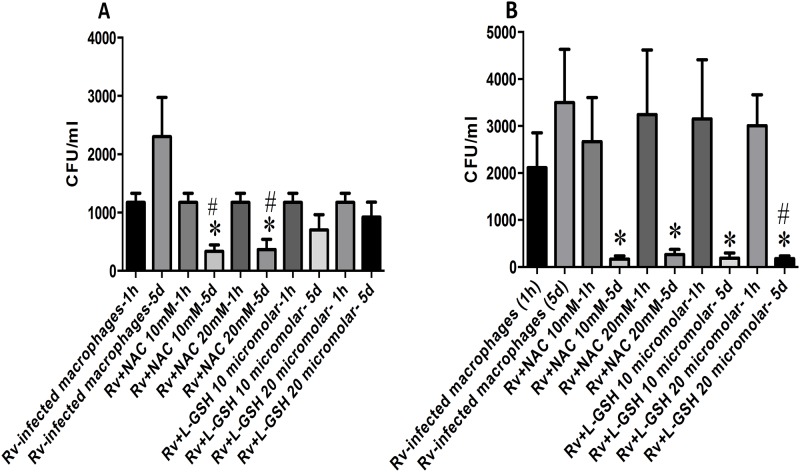
Intracellular survival of H37Rv in macrophages from healthy volunteers and individuals with T2DM.Macrophages were infected with H37Rv, a laboratory strain of M.tb, with multiplicity of infection 10:1. One hour post-infection, infected macrophageswere treated with 10 mM and 20 mM NAC and 10 μM and 20 μM lGSH. Infected macrophages were terminated at 1h and 5 days post-infection. Lysates were plated on 7H11 medium with ADC to determine M.tb growth. Data represent means ±SE from 5 healthy individuals (Fig. 9A) and 5 individuals with T2DM (Fig. 9B). Experiments were performed in triplicates. *p<0.05 when comparing H37Rv-infected macrophages 5 day time point results to any other 5 day time point categories while #p<0.05 when comparing 1 hour and 5 day time points of the same treatment category.